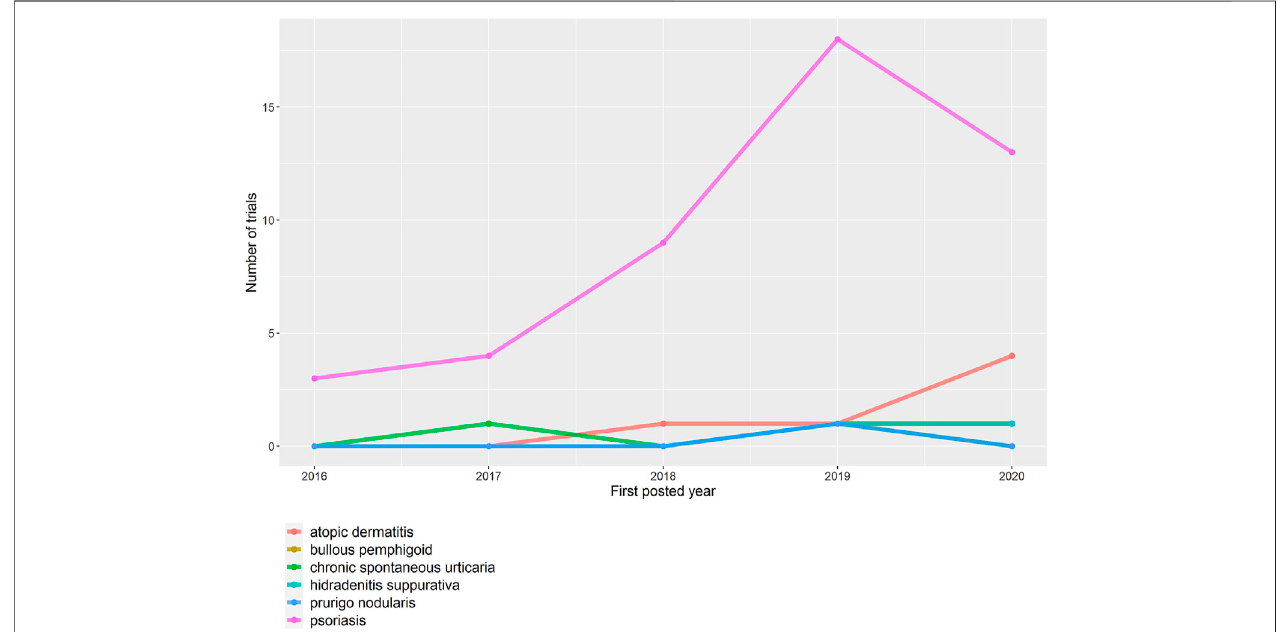
FIGURE 2 | Time trend of dermatological biologic trials in China by disease